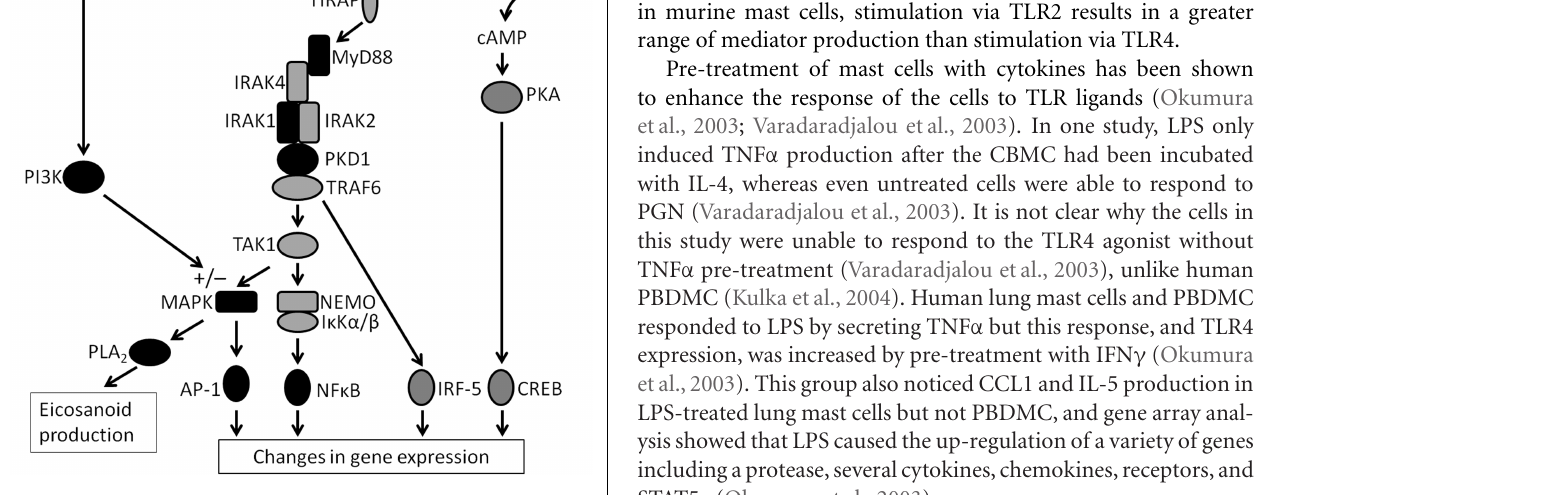
FIGURE 2 |TLR signaling in the mast cell. A scheme illustrating the signaling pathways triggered byTLR ligation in the mast cell.Where there is evidence in the literature for the involvement of a particular protein, the protein is filled in black. Proposed molecules are in grey (adapted from Akira etal., 2006; Lu etal., 2008; Park etal., 2009).The activation of PI3K via c-kit or Fc ε RI stimulation is shown, with its inhibitory and activating effects on MAPK